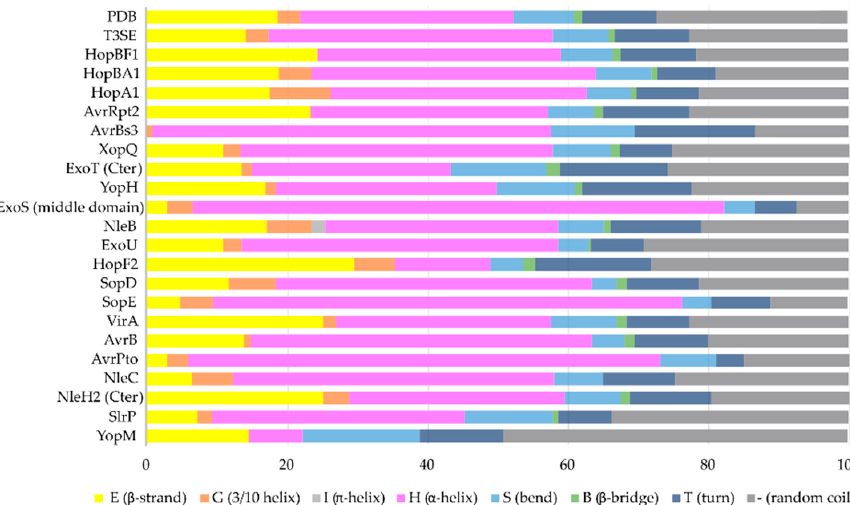
Figure 4. The secondary structure composition of T3SE domains in comparison to PDB. The average occurrence of α -helices in T3SEs is approximately 10% higher compared to the PDB proteome [25]. However, the information from the T3SE-determined crystal structures usually comes from the structured domains of the T3SEs, while their frequently unstructured/flexible N-terminal and C- terminal parts are usually missing from the determined crystal structures. Secondary structure assignments were performed for each PDB id presented in Figure 3. Table 1. List of the α -helical T3S effectors discussed in this